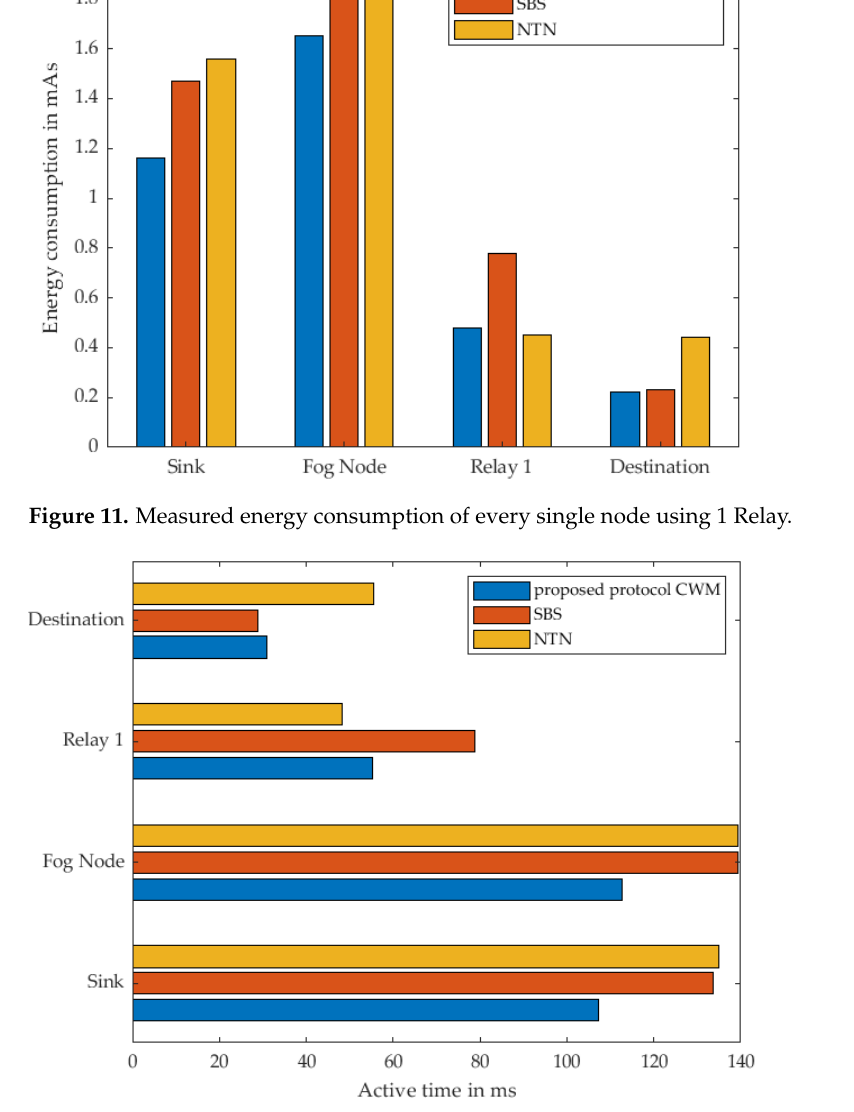
Figure 12. Measured time of every single node in active mode using 1